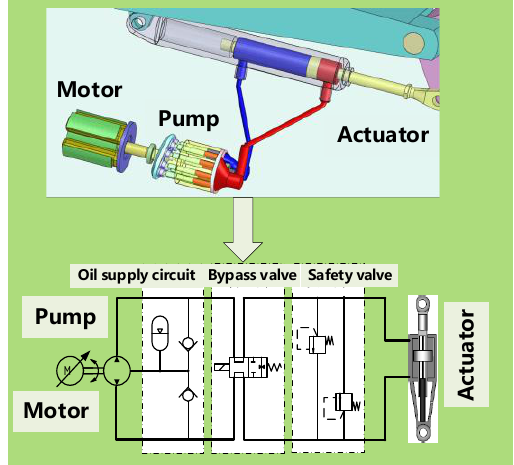
Figure 1. EHA structure &principle schematic.